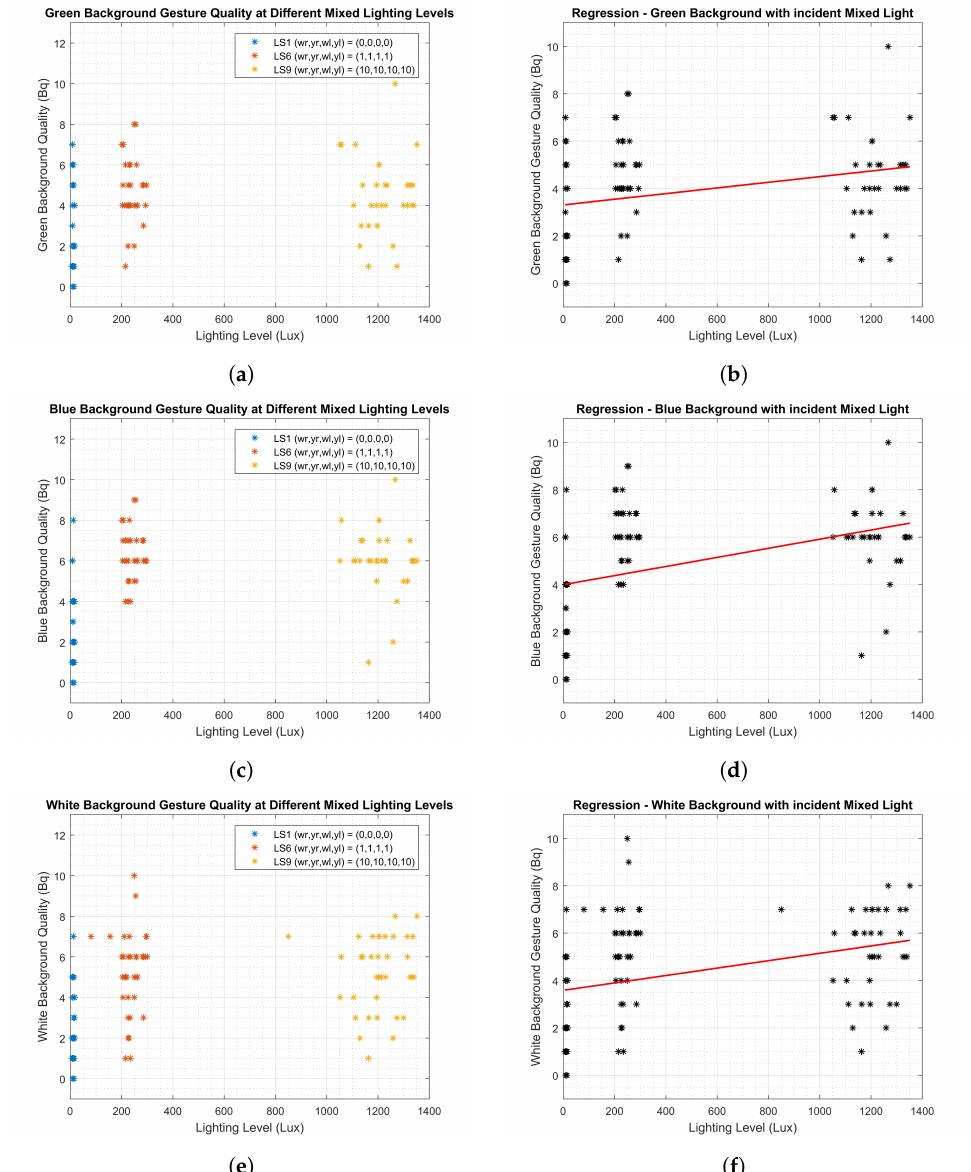
Figure 17. VLL mixed white and yellow incident LED light on green, blue, and white backgrounds. ( a ) VLL green background, ( b ) VLL green background regression, ( c ) VLL blue background, ( d ) VLL blue background regression, ( e ) VLL white background, ( f ) VLL white background